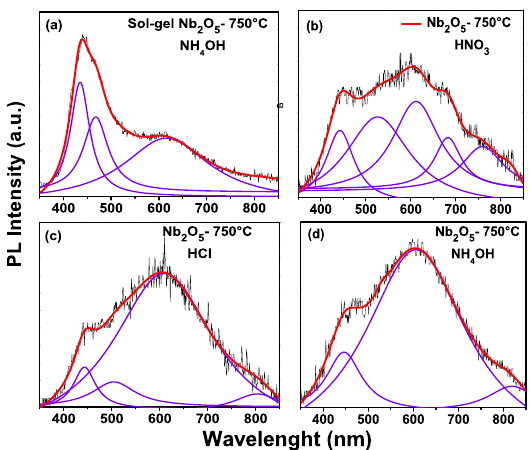
Figure 7. Photoluminescence spectra at room temperature at 750 ◦ C in Nb 2 O 5 : ( a ) Sol-gel (NH 4 OH); ( b ) Pechini (HNO 3 ); ( c ) Pechini HCl; and ( d ) Pechini (NH 4 OH).